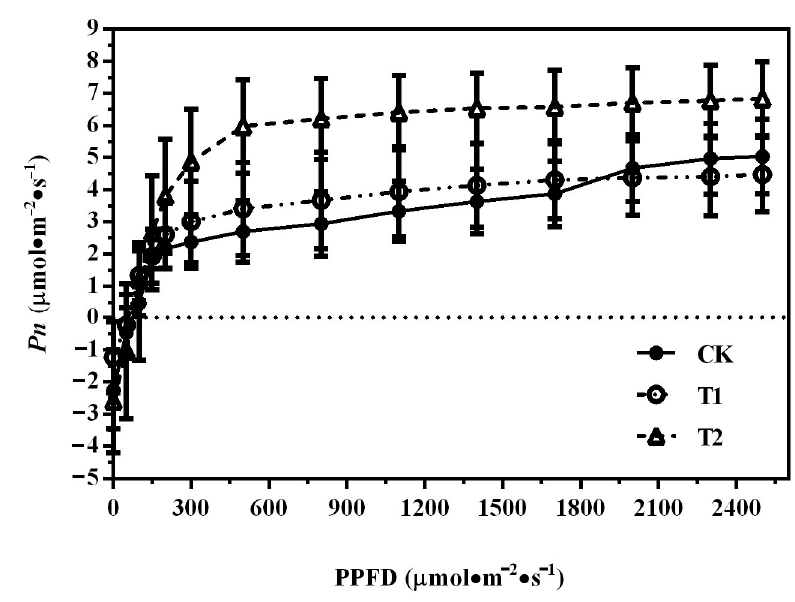
Figure 5. Photosynthetic light-response curves of ‘Misty’ in a plant factory with artificial lighting.